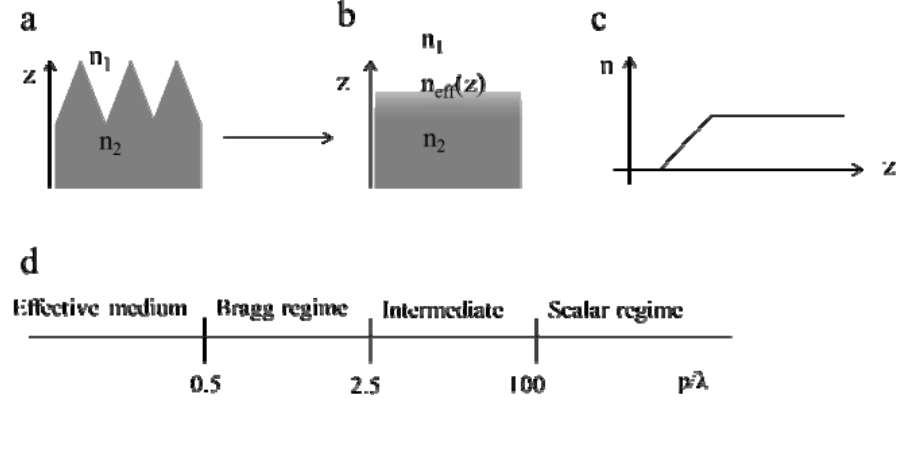
Figure 5. Schematic of a graded index subwavelength structure ( a ); the effective index of refraction according to how the light would interact with the material ( b ); and a graph of an approximate effective index ( c ); The various regimes of optical behavior with grating sizes are shown in ( d ), indicating that the effective medium theories are applicable for gratings whose periods (p) are much smaller than the wavelength of light ( λ